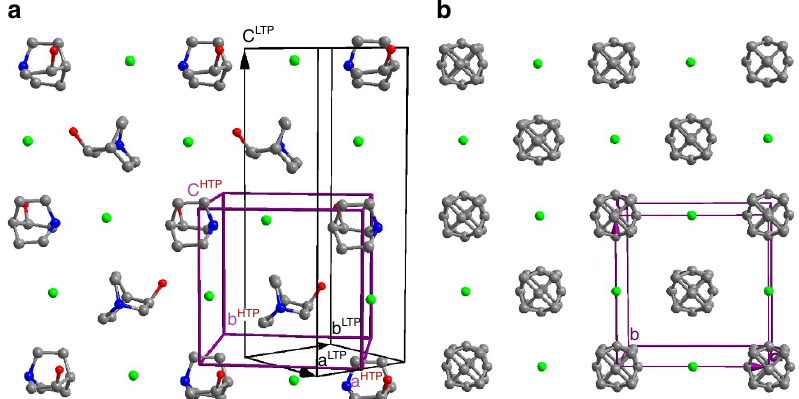
Figure 2 | The comparison of the crystal structures of the FP and PP. ( a ) A view of a [1 1 0] layer of the FP. The cell edges of both the FP and PP were drawn to show their relationship. ( b ) A view of a [0 1 0] layer of the